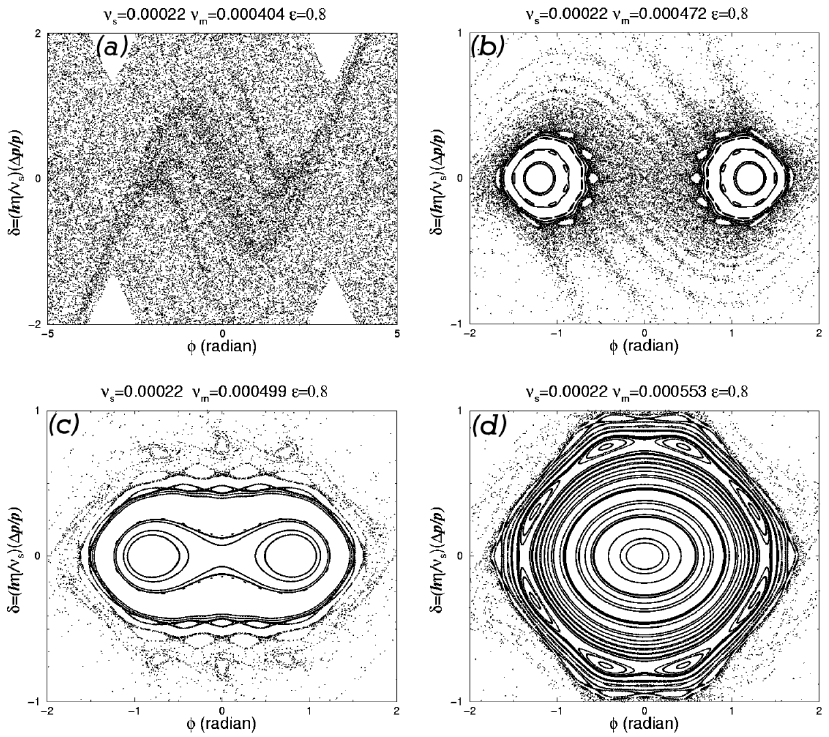
FIG. 3. Simulated particle trajectories in a surface of a section of the Hamiltonian (2). (a) Modulation tune 0.000 404, (b) modu- lation tune 0.000 472, (c) modulation tune 0.000 499, and (d) modulation tune 0.000 553. All cases are driven with a modulation amplitude of e (cid:1) 0.8 .